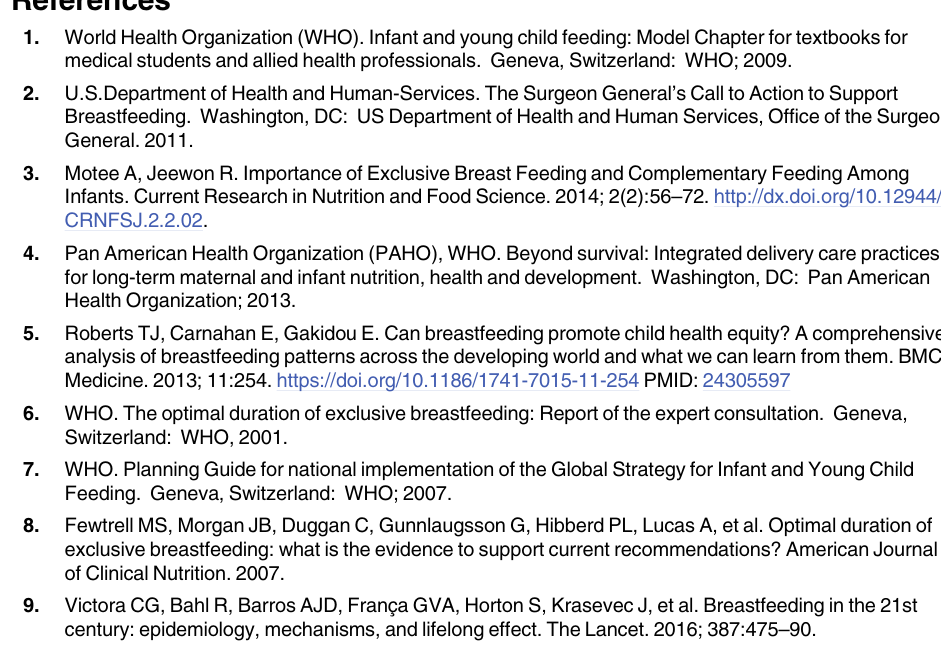
S1 Table. STROBE 2007 (v4) Statement—Checklist of items that should be included in reports of cross-sectional studies. S2 Table. Explanatory variables categorization and